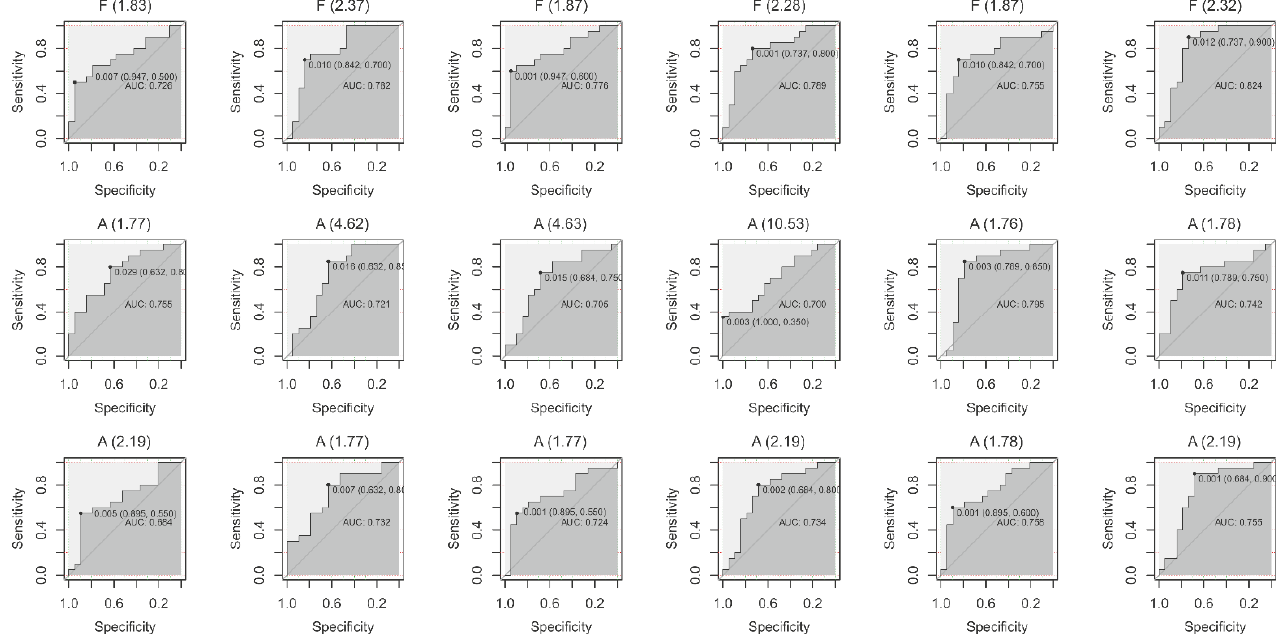
Figure 2. ROC curves for 18 significant peaks.